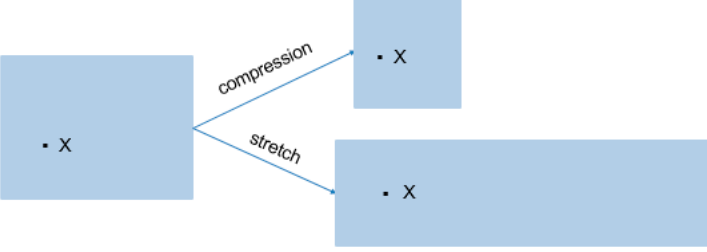
Figure 4. After the topological transformation of the rectangle, point X is still in the rectangle. This built-in property becomes a topological feature.